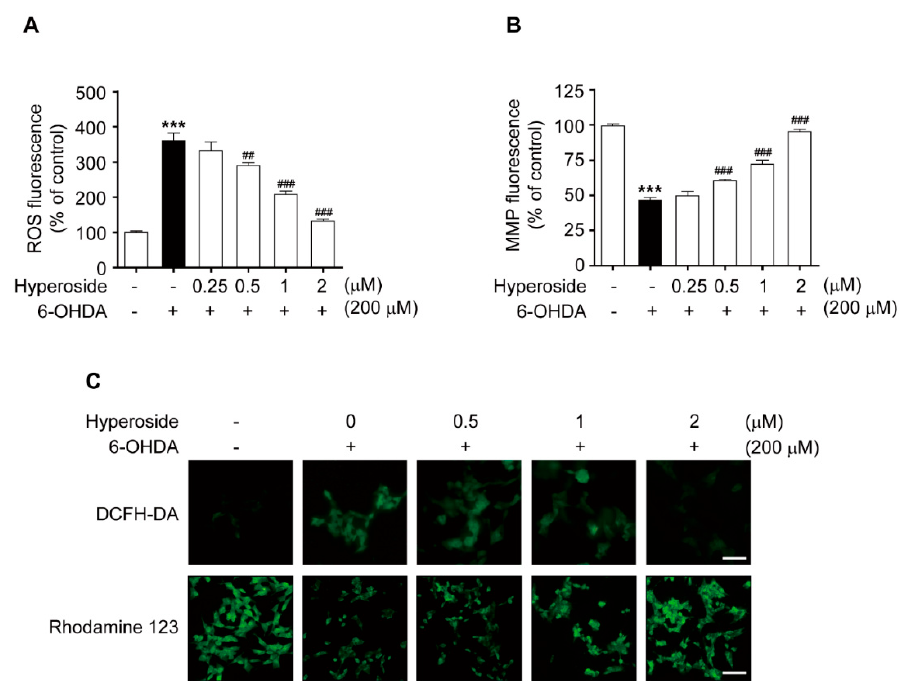
Figure 3. Hyperoside prevents 6-OHDA-induced intracellular Reactive Oxygen Species (ROS) accumulation ( A , C , upper) and mitochondrial membrane potential (MMP) dysfunction ( B , C , bottom) in SH-SY5Y cells. Representative images were observed under fluorescence microscopy (20 × ). Cells were pretreated with the hyperoside (0.25–2 µ M) for 4 h and then exposed to 200 µ M 6-OHDA for 1 or 24 h. Error bars indicate the mean ± SEM ( n = 6). Images shown are representative of three experiments and visualized by fluorescence microscopy (40 × ). *** p < 0.001 vs. control group. ## p < 0.01 and ### p < 0.001 vs. the 6-OHDA-treated group. Scale bar: 200 µ m.